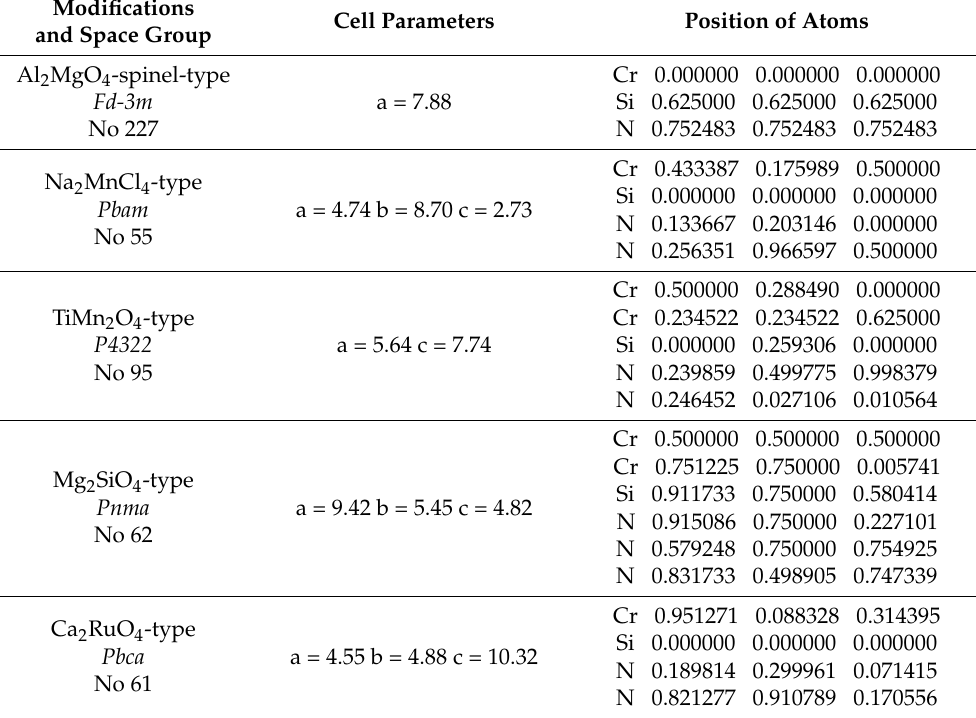
Table 5. The modifications, space groups, unit cell parameters, and atomic positions for Cr 2 SiN 4 modifications obtained from data-mining-based searches and local optimization at the GGA-PBE